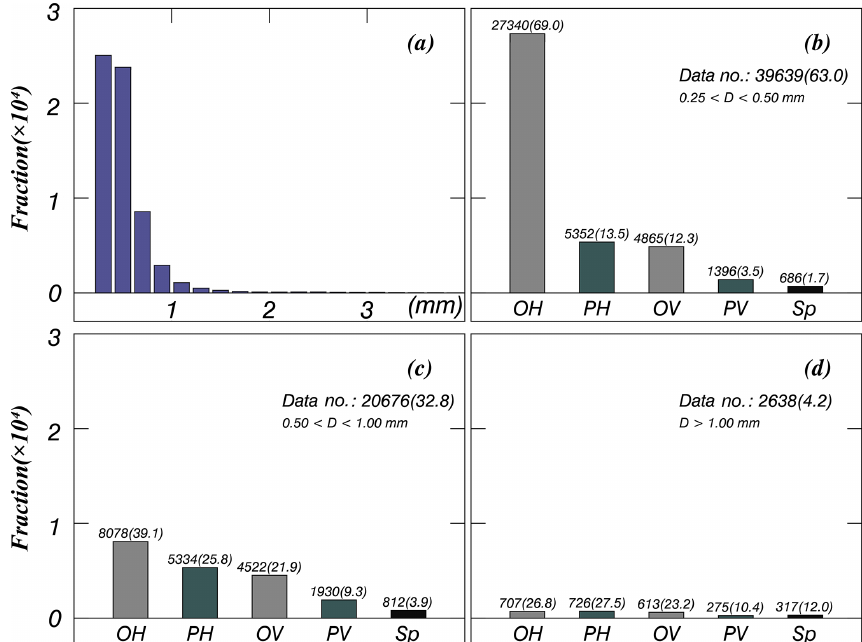
Figure 8. Histograms of volcanic ash particles for (a) all particle types and (b–d) each particle shape type of the phi scale. The grey-shaded and dark-grey-shaded (patterned) bars indicate horizontal oblate (OH) (vertical oblate, OV) and horizontal prolate (PH) (vertical prolate, PV), respectively. The black bar corresponds to spherical (Sp) particles. The number on the top of each bar plot is the number of data points, and the number in parentheses is the percentage for each phi